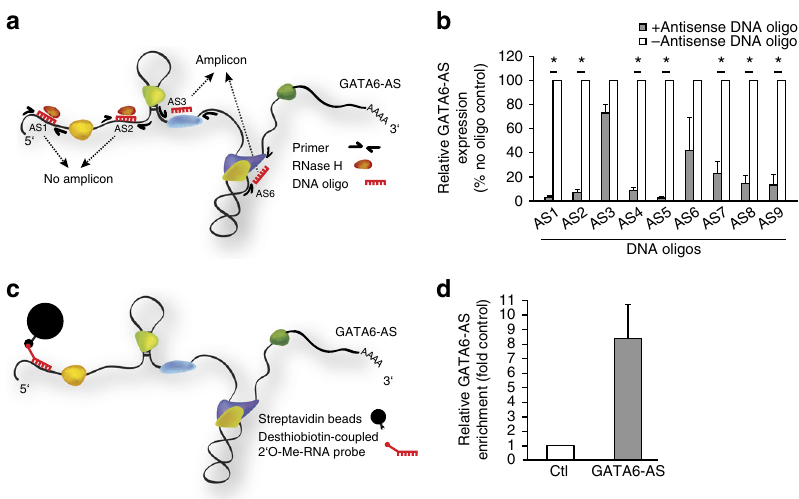
Fig. 3 Antisense af fi nity selection of endogenous GATA6-AS – protein complexes. a Scheme for testing oligonucleotide accessibility of GATA6-AS. Binding of antisense DNA oligonucleotides to accessible sites within the GATA6-AS transcript results in the formation of DNA-RNA-heteroduplexes and subsequent RNA cleavage by RNase H. Cleaved sites cannot be ampli fi ed by fl anking primers in subsequent RT-qPCR reactions. b DNA oligonucleotides (AS1 – 9; see Supplementary Fig. 1b for details) targeting GATA6-AS were incubated in HUVEC cellular extract and RNase H was added to degrade DNA- RNA-heteroduplexes. Following RNA preparation, RT-qPCR was used to assay for accessible sites. In control reactions, DNA oligonucleotides were omitted ( n = 3; SEM; * t test p < 0.05). c Scheme for purifying endogenous GATA6-AS – protein complexes. An oligonucleotide-accessible site within GATA6-AS is targeted by a desthiobiotin-coupled 2 ′ O-Me-RNA probe. Subsequently, the complex is recovered using streptavidin beads. d HeLa cell lysate was used to capture endogenous GATA6-AS – protein complexes by RNA af fi nity selection (AS1 probe). As control, scrambled 2 ′ O-Me-RNA probes were used. Following elution with biotin, co-puri fi ed RNA fractions were analyzed for GATA6-AS enrichment by RT-qPCR ( n = 4; SEM)